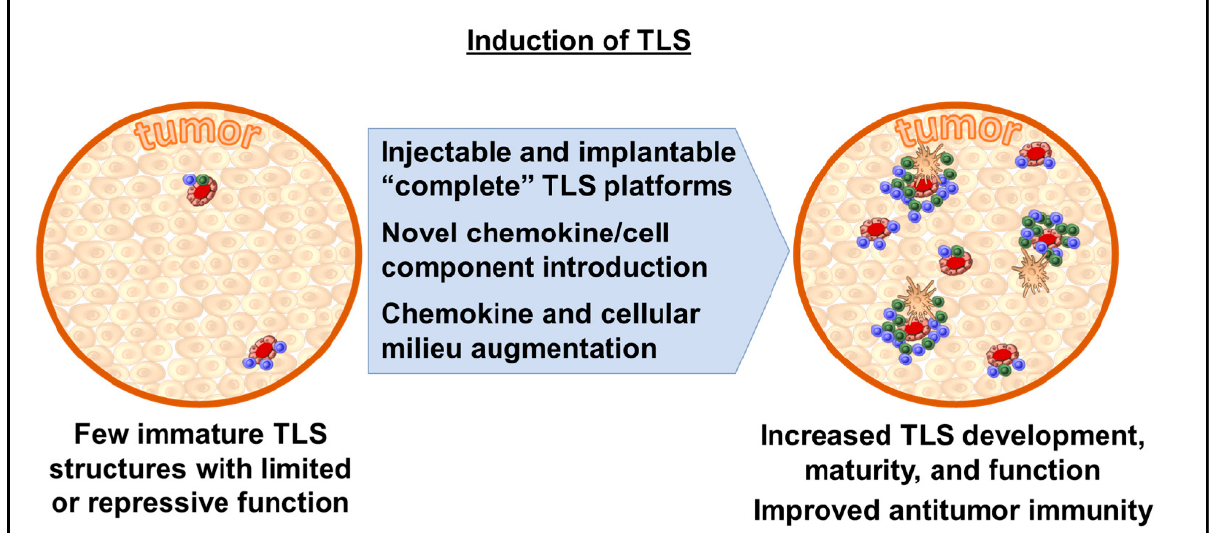
Figure 2. Methods of inducing TLS within tumor microenvironment.